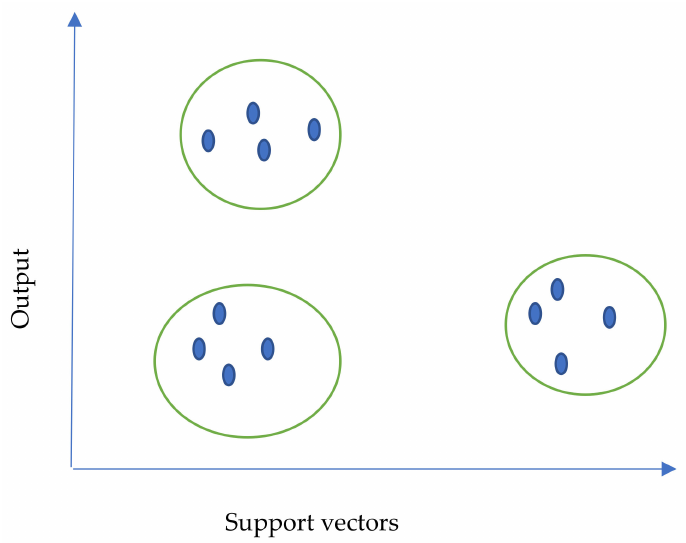
Figure 2. Hyperplanes for